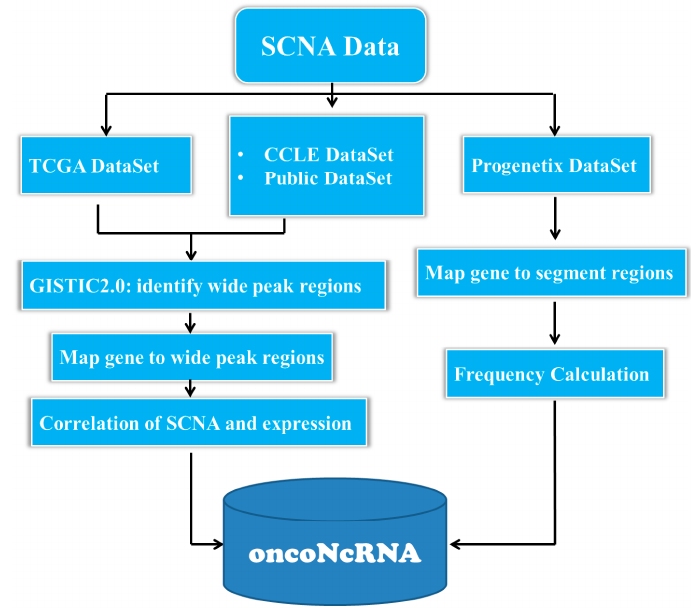
Figure 1. The workflow of oncoNcRNA web portal. We integrated large-scale somatic copy number alteration (SCNA) data from The Cancer Genome Atlas (TCGA), Cancer Cell Line Encyclopedia (CCLE) and other published papers, and provided the correlation of expression level and copy number